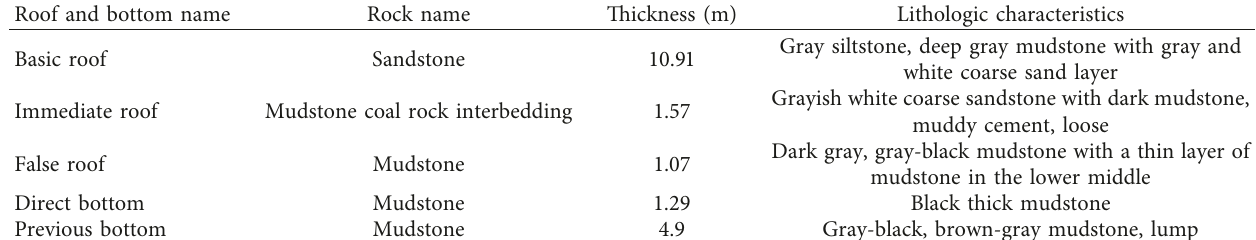
Table 9: Coal seam roof and bottom conditions on N101 working face.